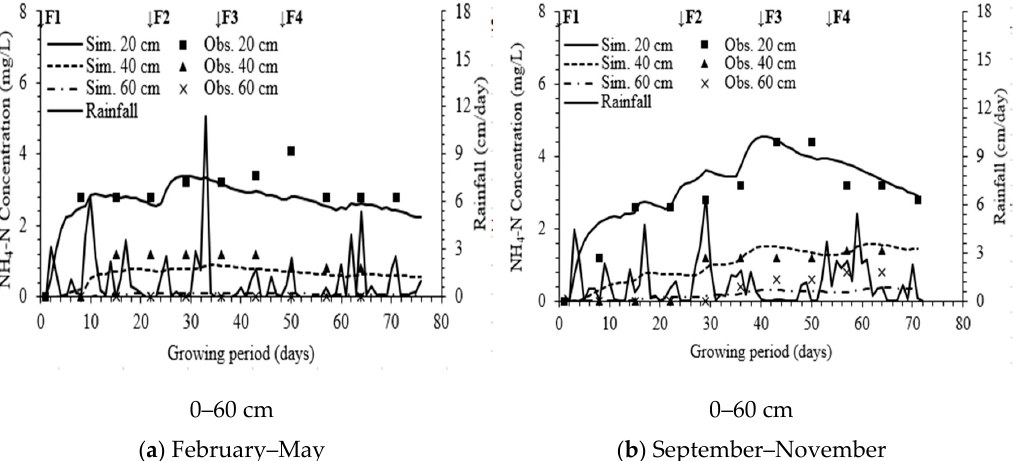
Figure 7. Comparison of simulated (Sim.) and observed (Obs.) NH 4+ -N concentrations during the ( a ) first season and ( b ) second season.